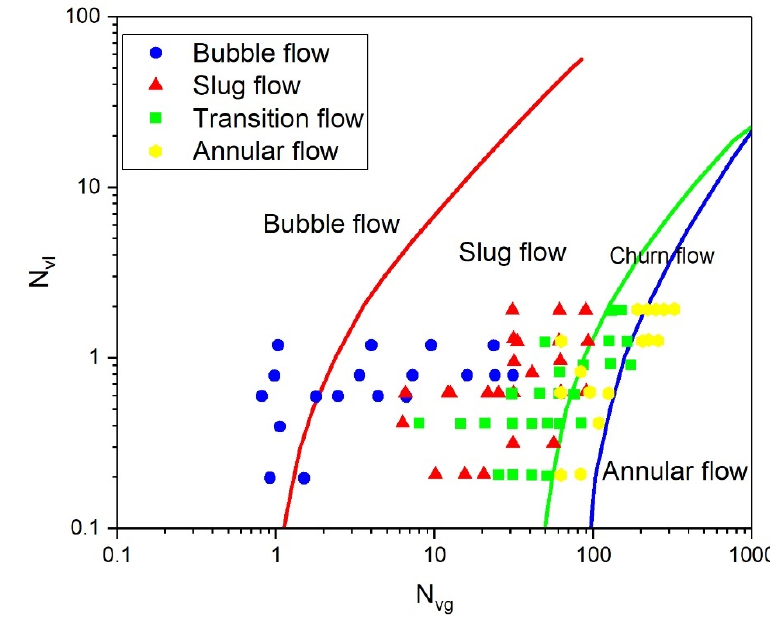
Figure 4. Application of Aziz–Govier–Fogarasi model flow pattern discrimination formula.